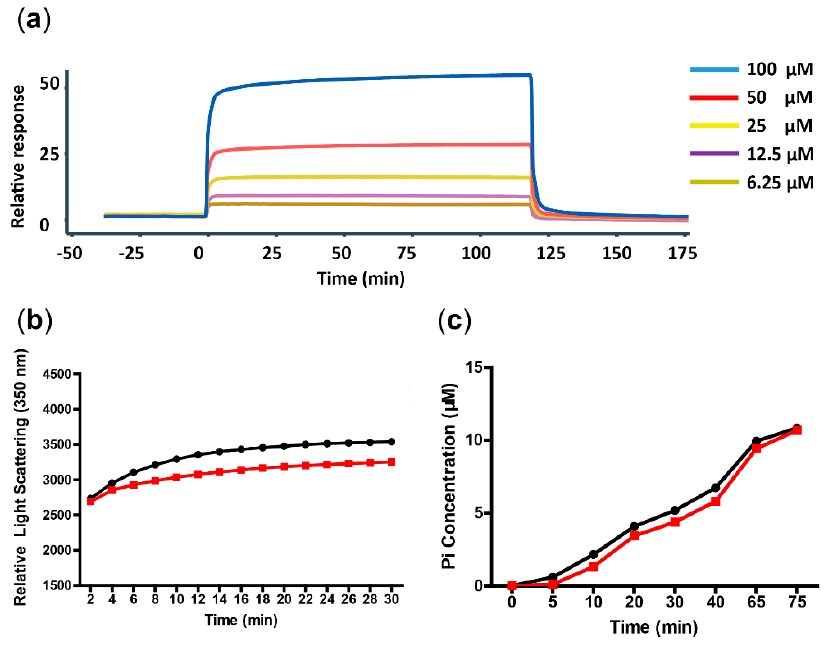
Figure 3. The in vitro interaction of FtsZ with AP-3. ( a ) The interaction of FtsZ with AP-3, determined by Biacore biosensor assay. 6.25, 12.5, 25, 50 or 100 µ M AP-3 flowed over a CM5 chip pre-immobilized with FtsZ. The response signals were recorded. ( b ) The inhibition of FtsZ assembly by the supplementation of AP-3, as detected by the real-time light scattering assay. Fluorescence signals of the reactions with (red line) or without (black line) 500 µ M AP-3 were recorded every 2 min. ( c ) The impact of AP-3 (500 µ M) on the GTPase activity of FtsZ, as detected by the Malachite Green Phosphate Assay Kit. Black line, without AP-3; Red line, with AP-3.